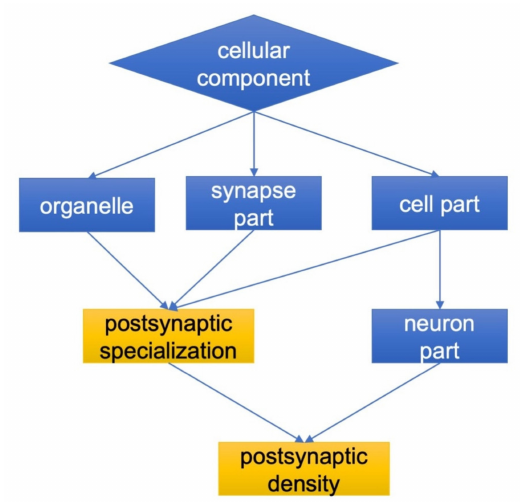
Figure 2. Cellular localization and functional links of brain isatin-binding proteins specific to isatin-treated mice. Details are given in the Materials and Methods